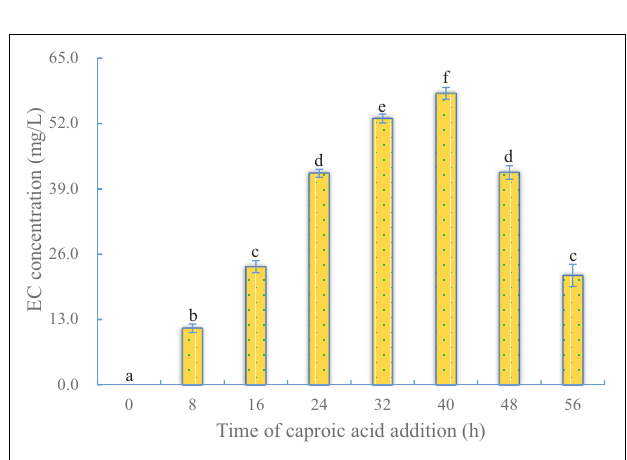
FIGURE 5 | Effect of time of caproic acid addition on EC production by YX3307. Same letters in the column indicates that the data do not differ significantly at 5% probability by the Tukey